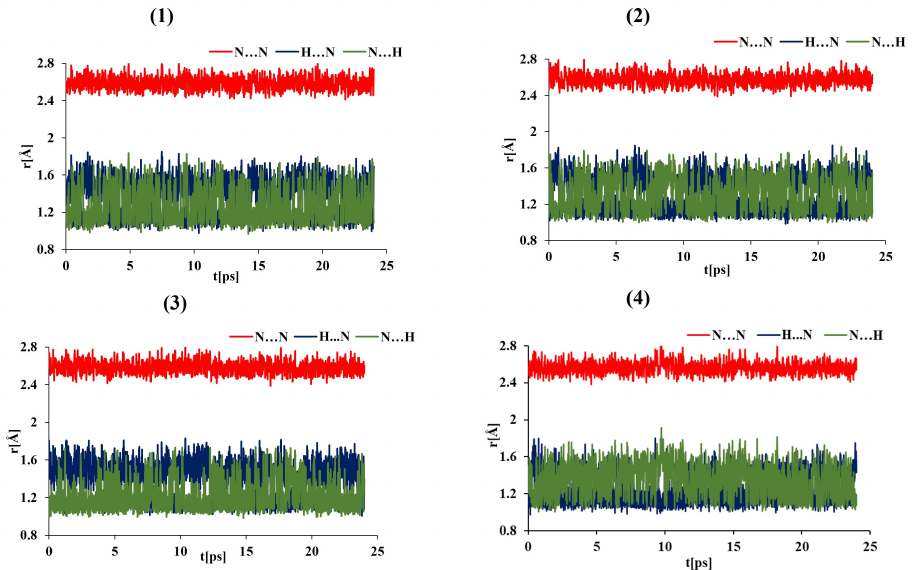
Figure 7. Time evolution of the hydrogen bond metric parameters. Crystalline-phase CPMD results at 300 K for DMANH + and its